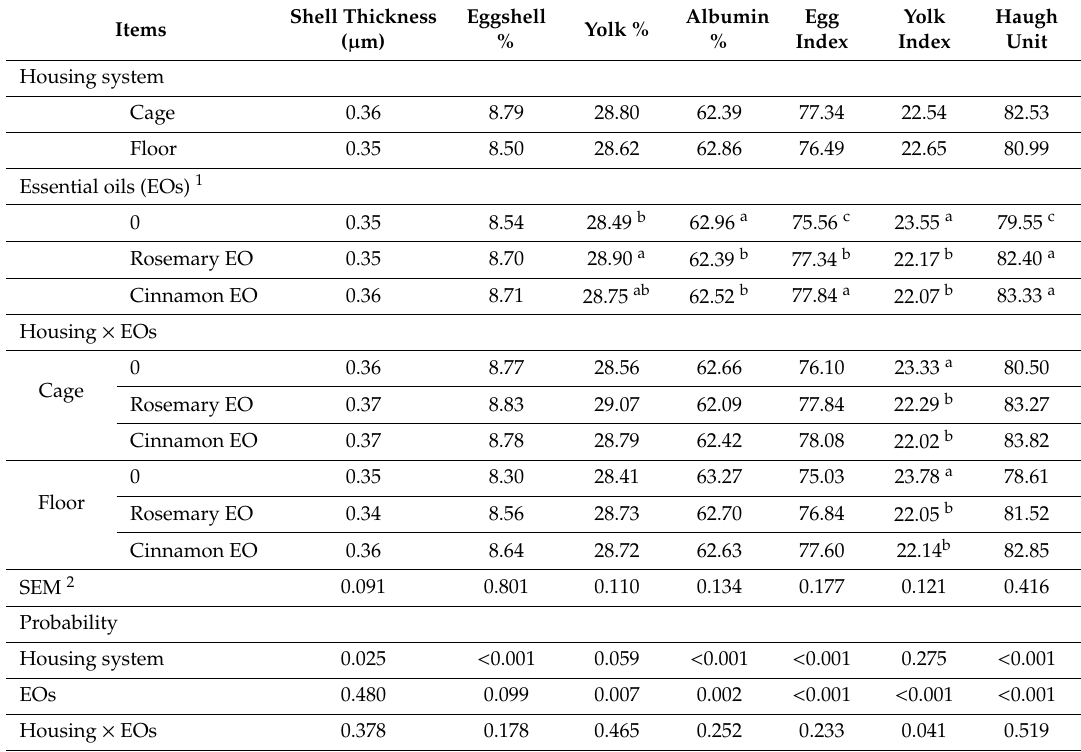
Table 7. Egg quality of laying hens as a ff ected by di ff erent housing systems, essential oils and their interaction during the